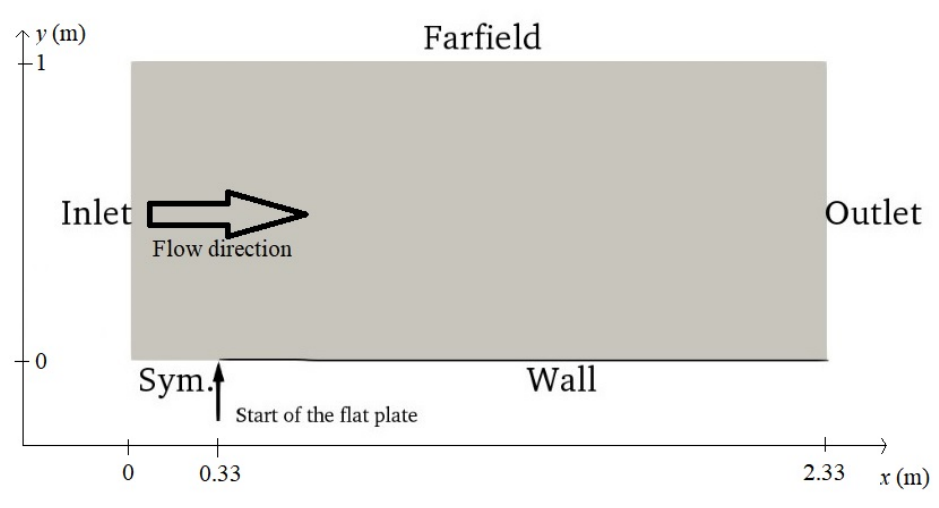
Figure 2. Visual representation of the computational domain.